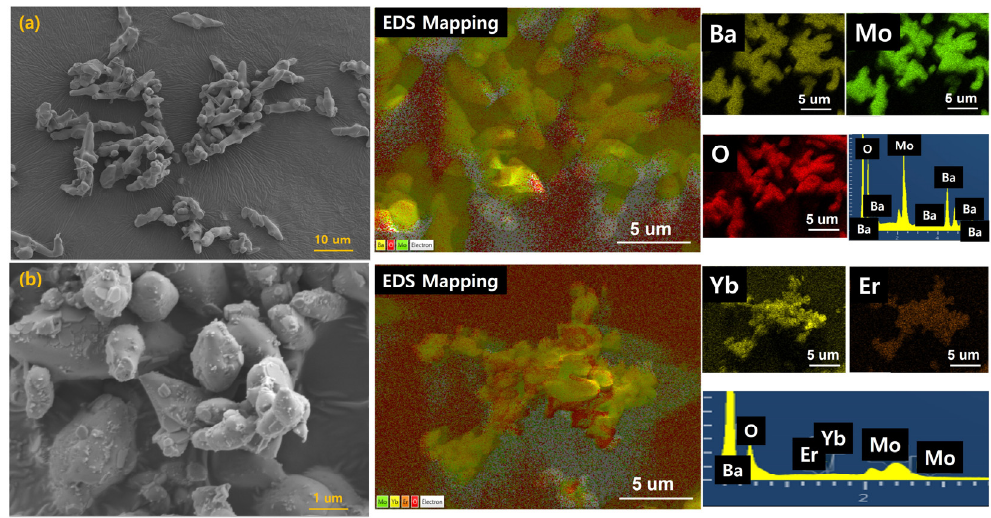
Figure 3. FE-SEM image and EDS Mapping analysis of ( a ) BaMoO 4 and ( b ) BaMoO 4 :[Er 3+ ]/[Yb 3+ ] powder.